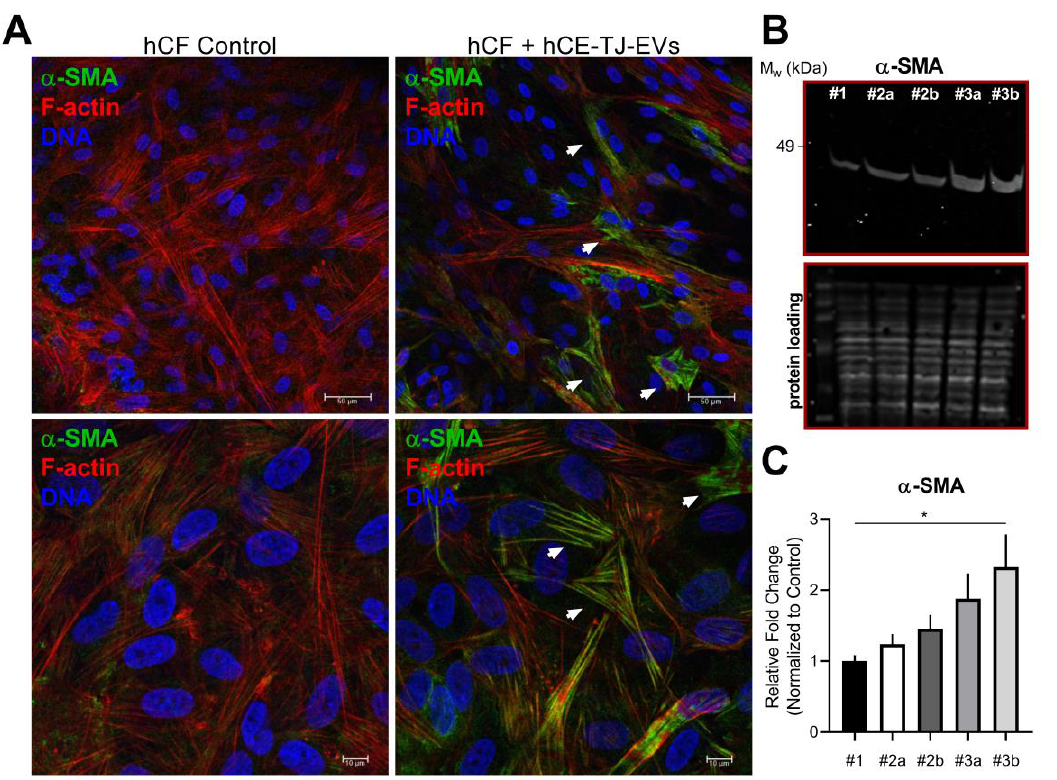
Figure 4. hCE-TJ-derived EVs increase stress fibers and protein expression of the myofibroblast marker, α -SMA, by hCFs. ( A ) Representative low-magnification ( top ) and high-magnification ( bottom ) immunofluorescence images of hCF controls and hCFs treated with hCE-TJ-derived EVs. Arrowheads denote the presence of stress fibers associated with elevated α -SMA expression. n = 3. α -SMA = green; phalloidin (F-actin) = red; Nuclei (DNA) = blue. Scale bars = 50 µ m ( top ) or 10 µ m ( bottom ). ( B ) Western blot analysis of α -SMA in hCF control (#1), hCFs treated with hCE-TJ-derived EVs [#2a (non-debrided) and #2b (debrided)], and hCFs treated with hCE-TJ-conditioned medium containing both free- and EV-bound factors [#3a (non-debrided) and #3b (debrided)]. Predicted molecular weight ( α -SMA) = 42 kDa. ( C ) Quantification of the α -SMA Western blot. n = 3 for control and n = 4 for each treated group. Each lane was loaded with 50 µ g of total protein. Error bars represent SEM. Statistical analysis determined using a one-way ANOVA. * p ≤ 0.05.